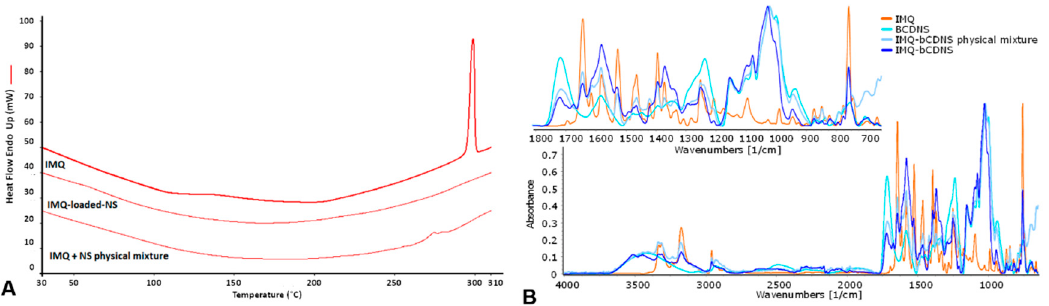
Figure 3. ( A ) DSC thermograms of IMQ ( A ), IMQ–NS physical mixture ( B ) and IMQ-loaded